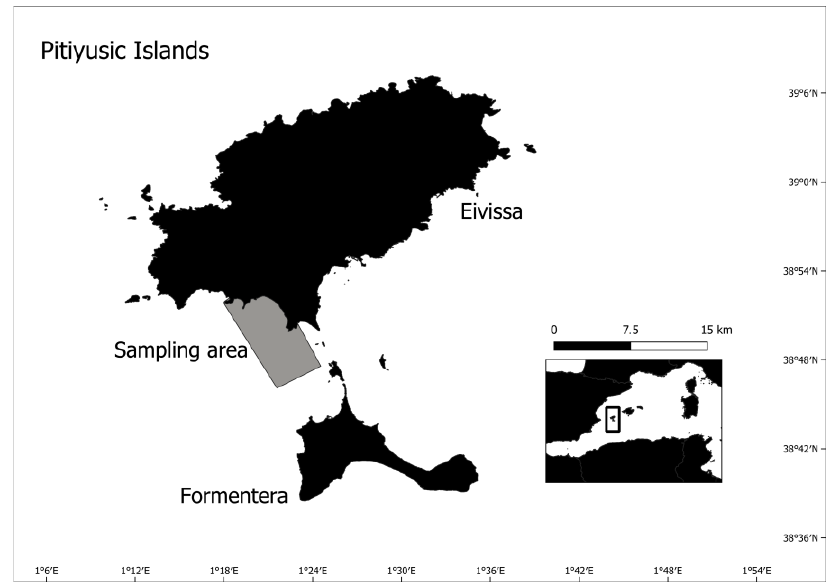
Figure 1. Location of Eivissa Island (Balearic Islands, Spain, Western Mediterranean) with the sampling area in grey colour.